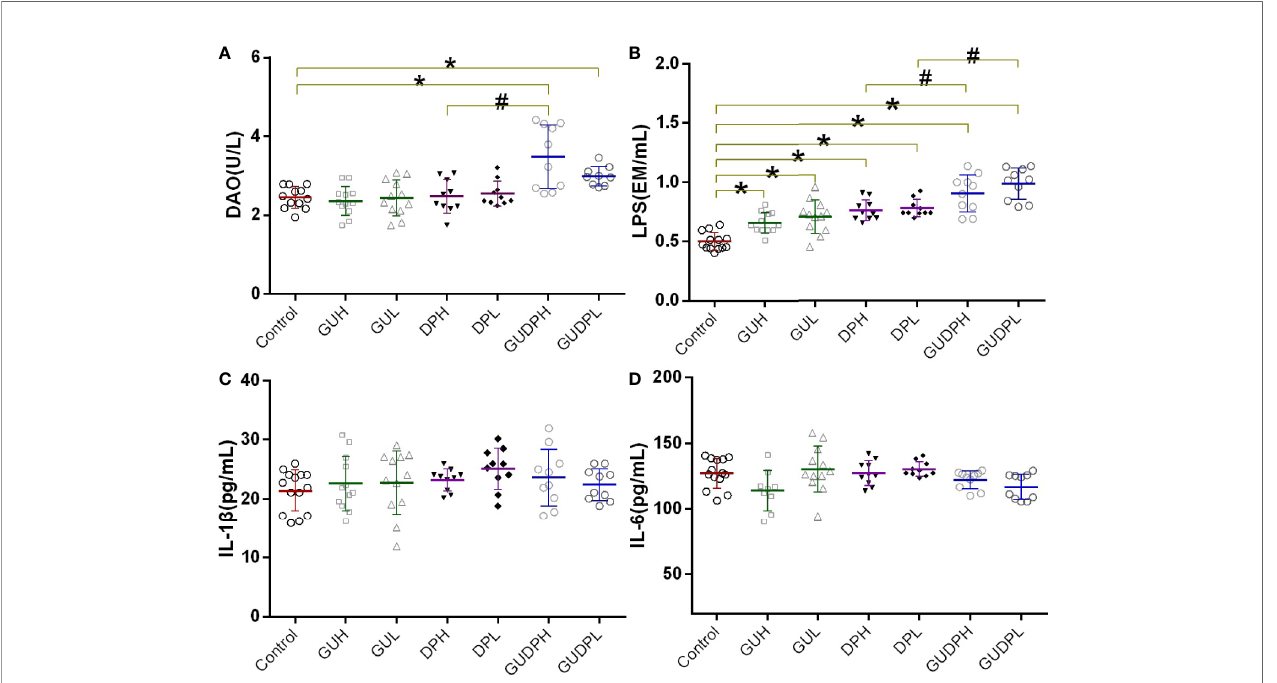
FIGURE 4 | Mouse serum biomarkers related to mucosal tissue and barrier function damage. (A) Serum DAO levels of mice. (B) Serum LPS levels of mice. (C, D) Serum cytokine levels of mice. *P < 0.05 compared with control group, # P < 0.05 compared between GUDPH and DPH groups or between GUDPL and DPL groups, as indicated by connecting lines. GUH, licorice high dose; GUL, licorice low dose; DPH, yuanhua high dose; DPL, yuanhua low dose; GUDPH, herbal pair high dose; GUDPL, herbal pair low